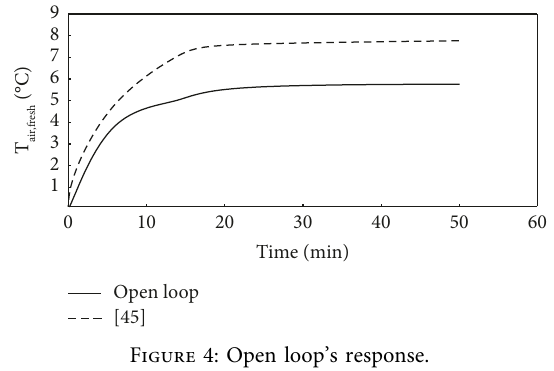
Figure 4: Open loop’s response.